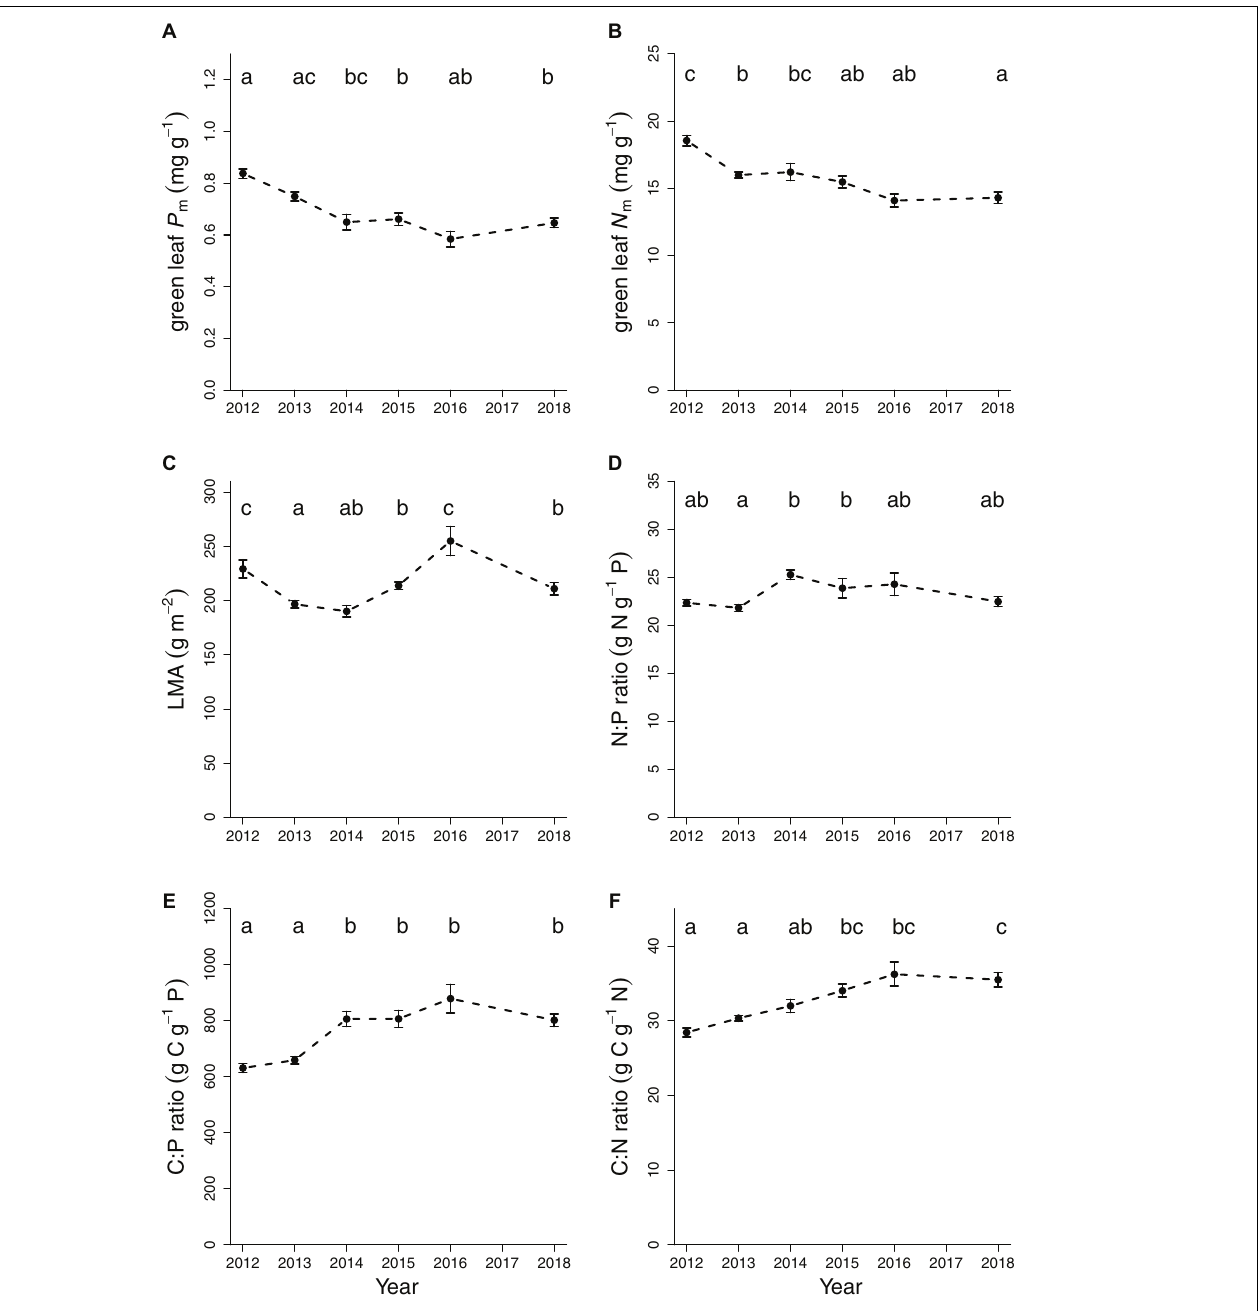
FIGURE 2 | Annual variation in chemistry and structure for mature green leaves averaged across measurement campaigns for (A) mass-based phosphorus in mg g − 1 , (B) mass-based nitrogen in mg g − 1 , (C) LMA in g m − 2 , (D) N:P ratio, (E) C:P ratio and (F) C:N ratio. Data are means and standard errors. There were no mature green leaves in February 2017 due to early flushing.